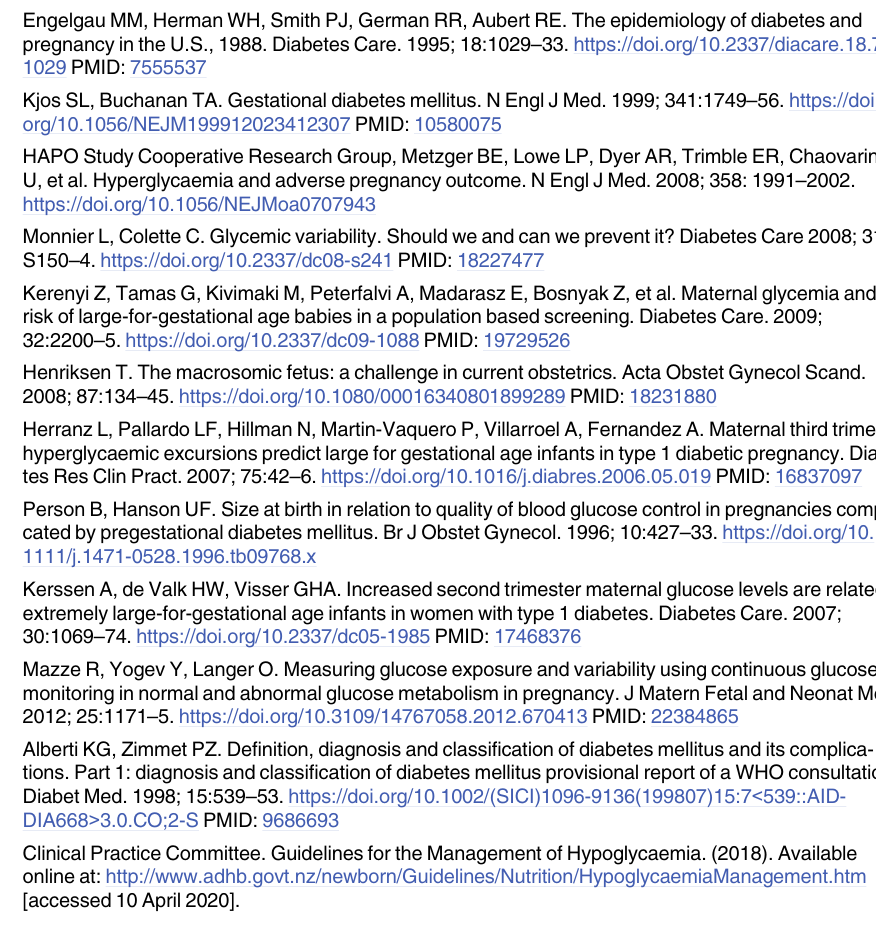
S2 Table. STROBE